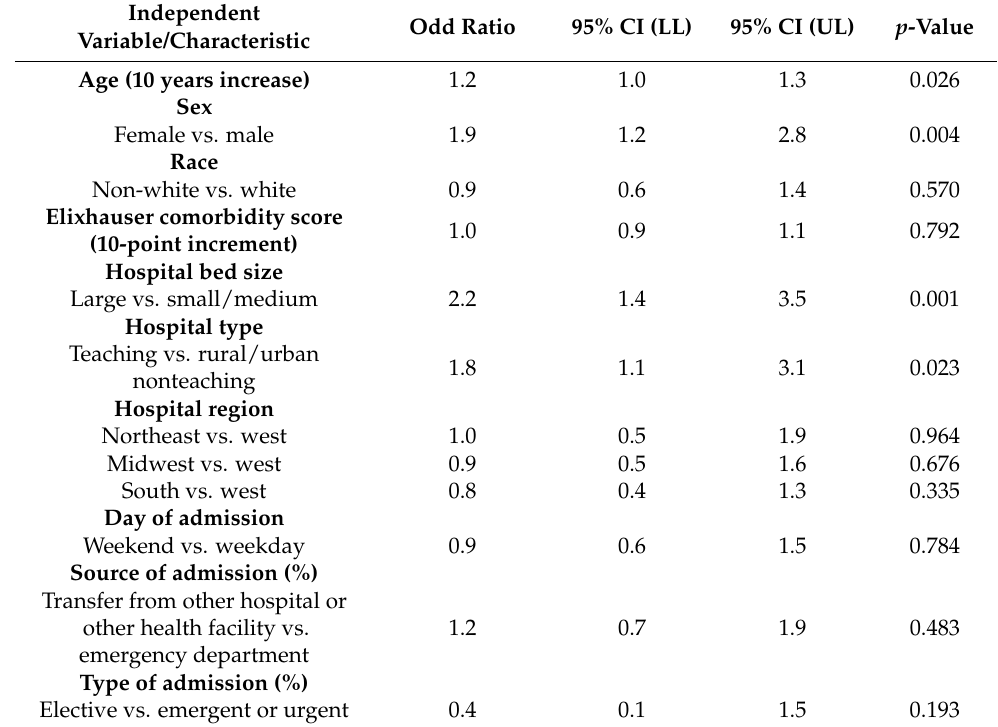
Table 3. Predictors of mortality in mechanical